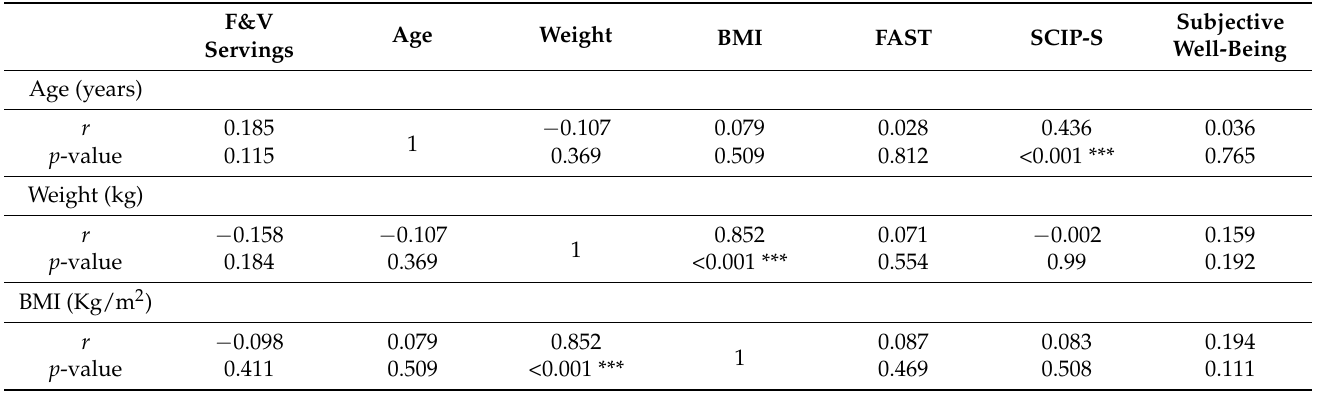
Table A2. Pearson’s correlation between sociodemographic and clinical variables and F&V